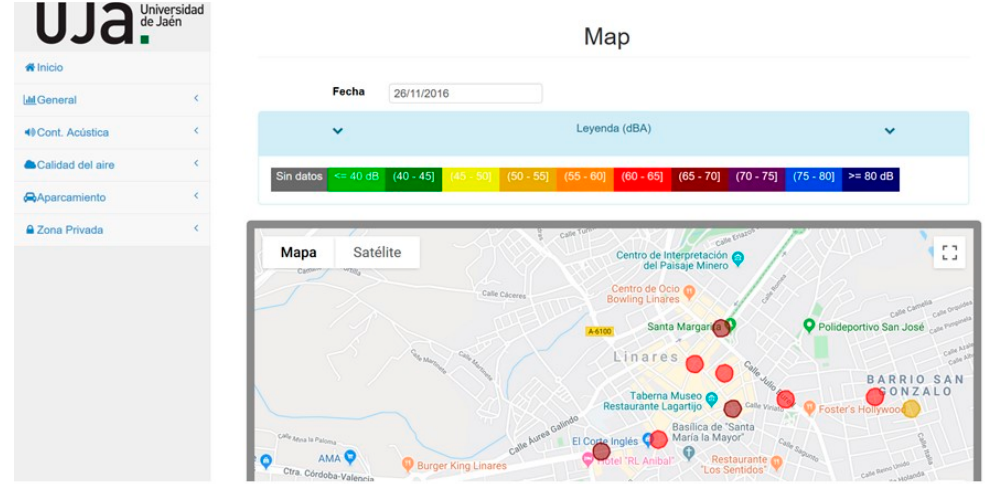
Figure 11. The map with the noise in the sensor locations on 26 November 2016.